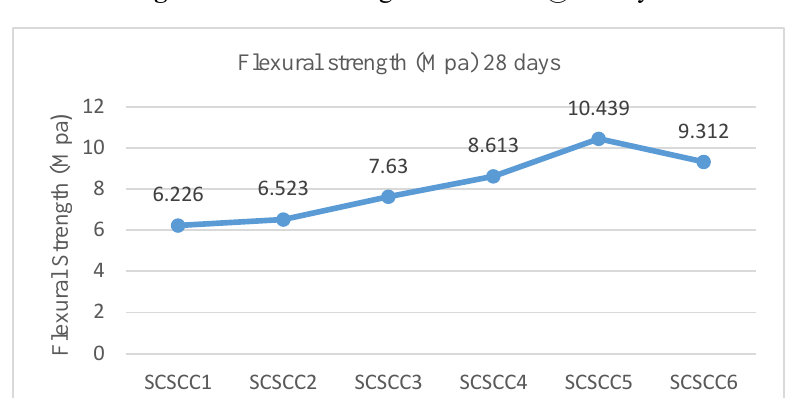
Fig. 20. Flexural Strength of NSSCC @ 28 days.